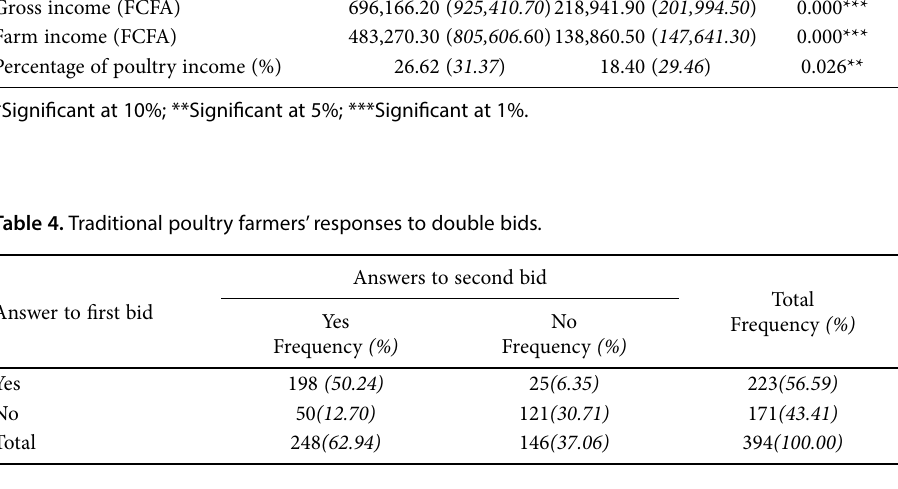
Answer to first